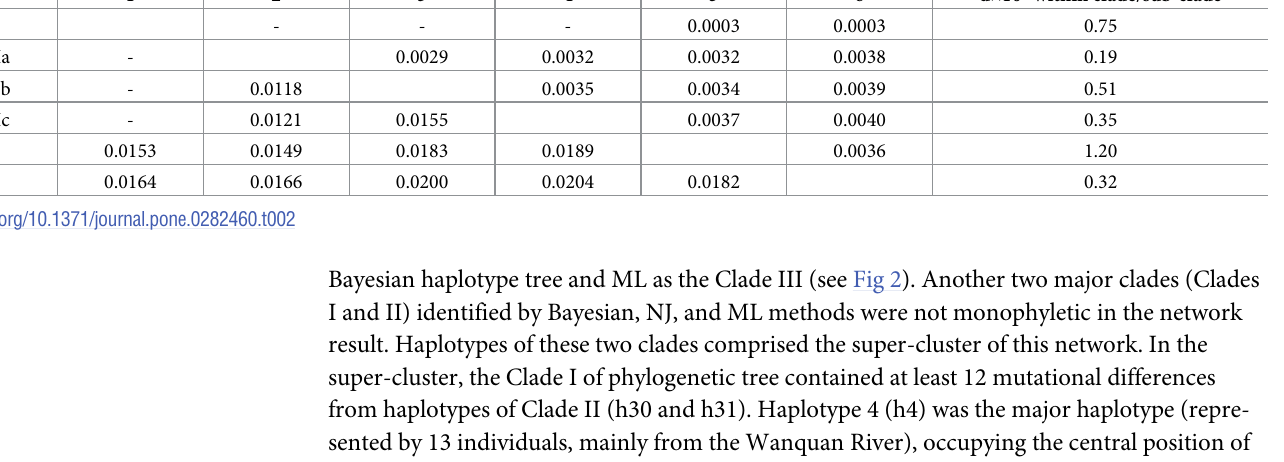
Table 2. Estimates of evolutionary divergence (K2P) between sequence pairs between clades/sub-clades (below) and standard errors (above).